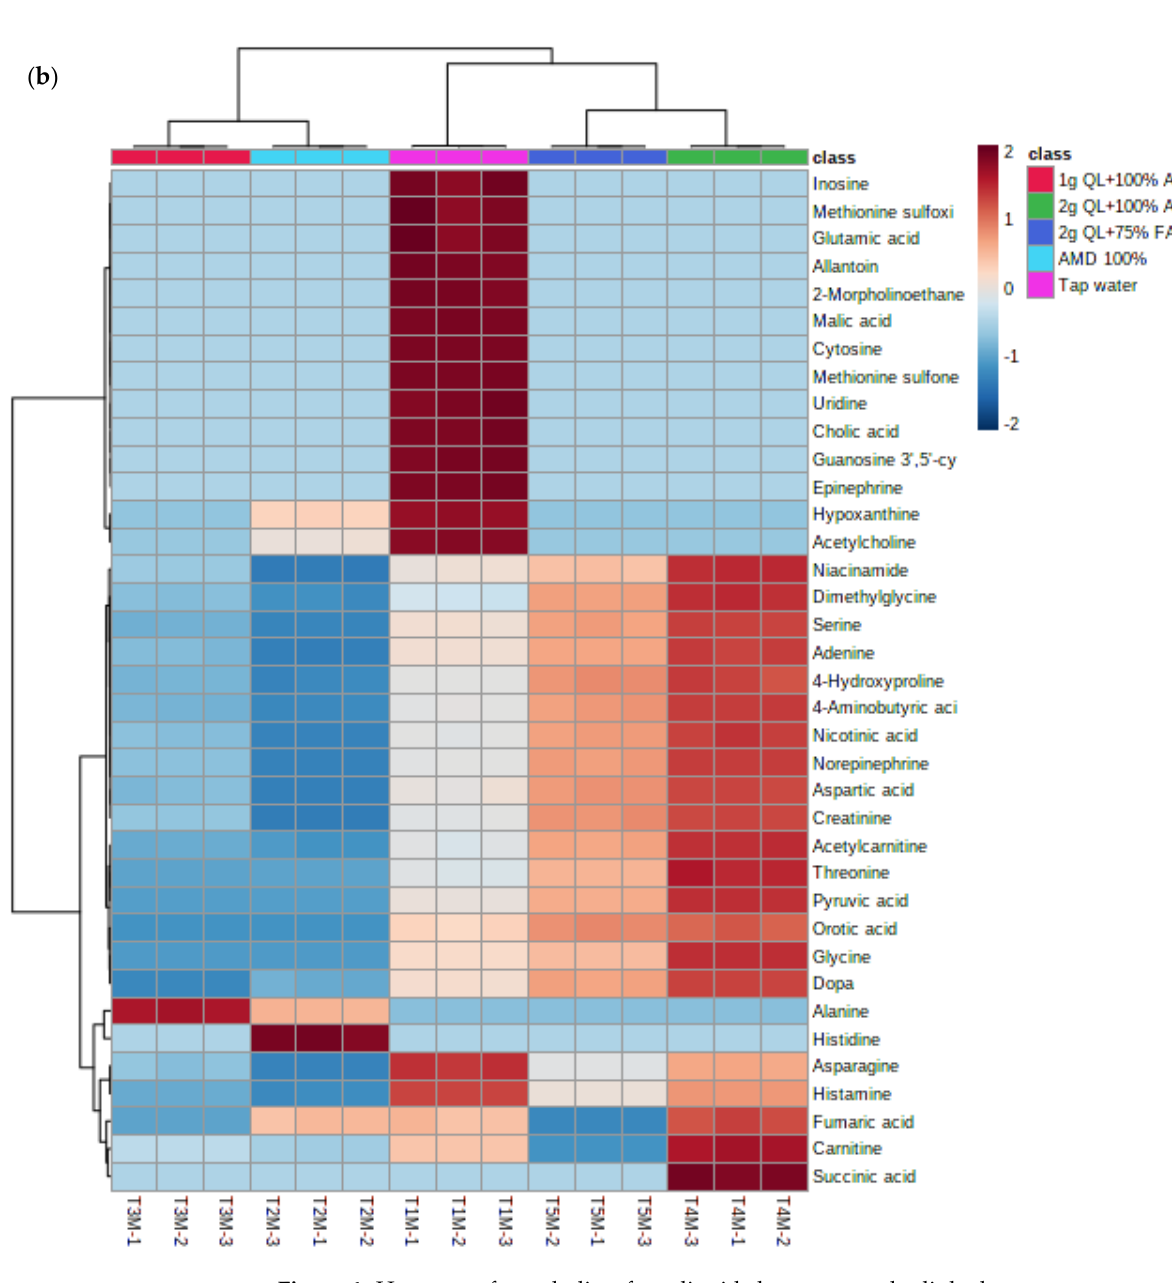
Figure 4. Heatmap of metabolites from liquid chromatography linked to mass spectrometry data of samples from Marykies ( a ) and Royal ( b ) potato tuber samples. Different colors denote different treatments: tap water (T1): purple, AMD 100% (T2): light blue, 1 g QL + 100% (T3): red, 2 g QL + 100% AMD (T4): green and 2 g QL + 75% FA (T5): dark blue, respectively.